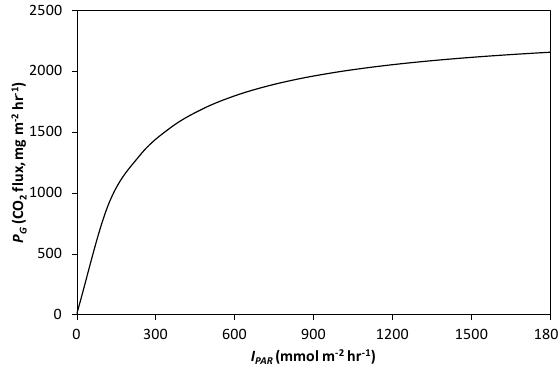
Figure 1. Example response of gross photosynthesis ( P ) to changes in solar G